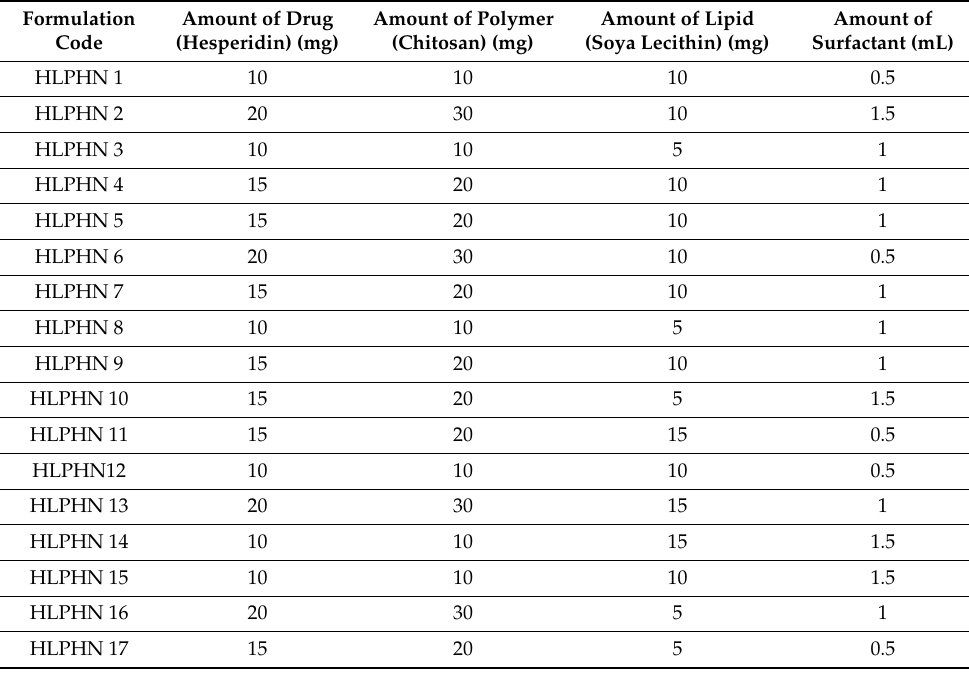
Table 6. Composition of